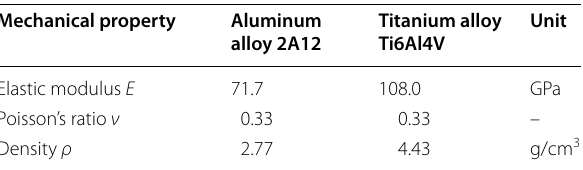
Table 3 Mechanical properties of the 2A12 aluminum alloy and Ti6Al4V titanium alloy